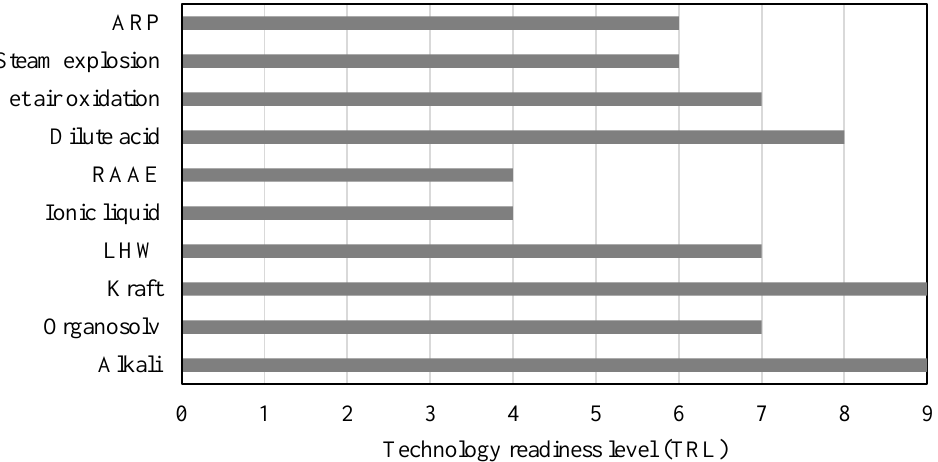
Figure 1. Technology readiness level of the selected lignocellulosic pretreatments.